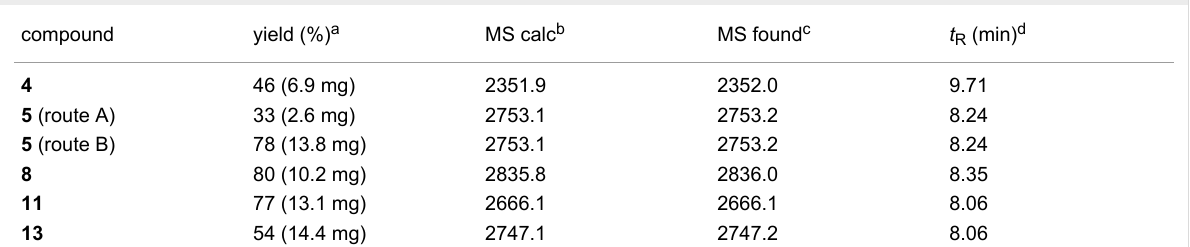
Table 1: Analytical data of the